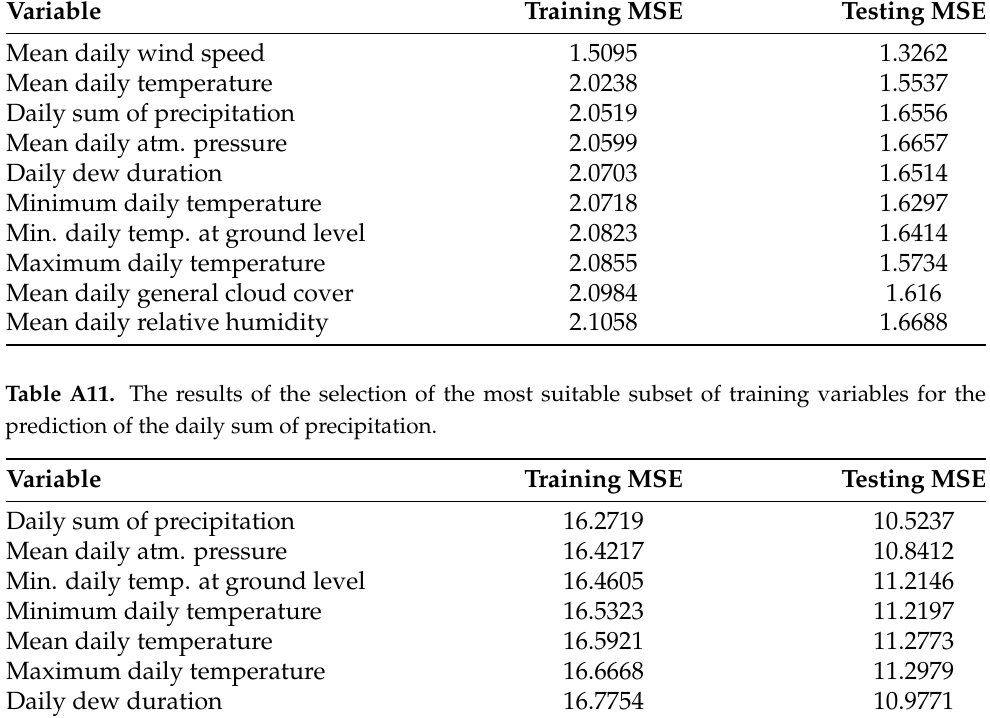
Table A10. The results of the selection of the most suitable subset of training variables for the prediction of the mean daily wind speed.